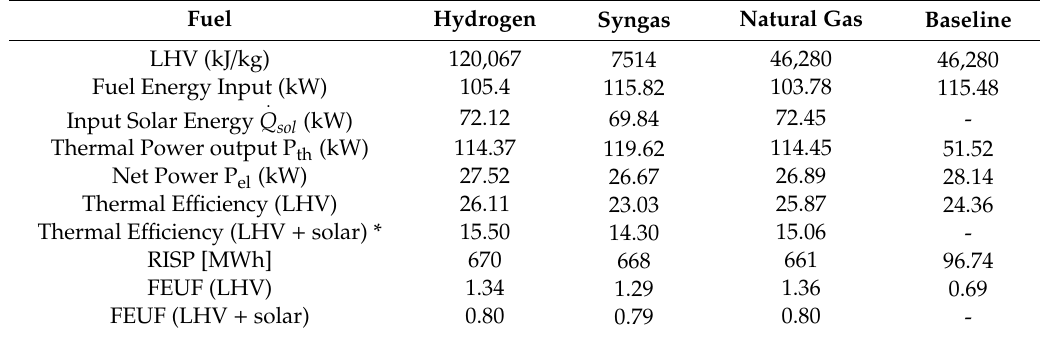
Table 6. Overall plant performance and cogeneration index for the investigated plant for three di ff erent fuels; the baseline case is the mGT fueled by NG without solar field and energy